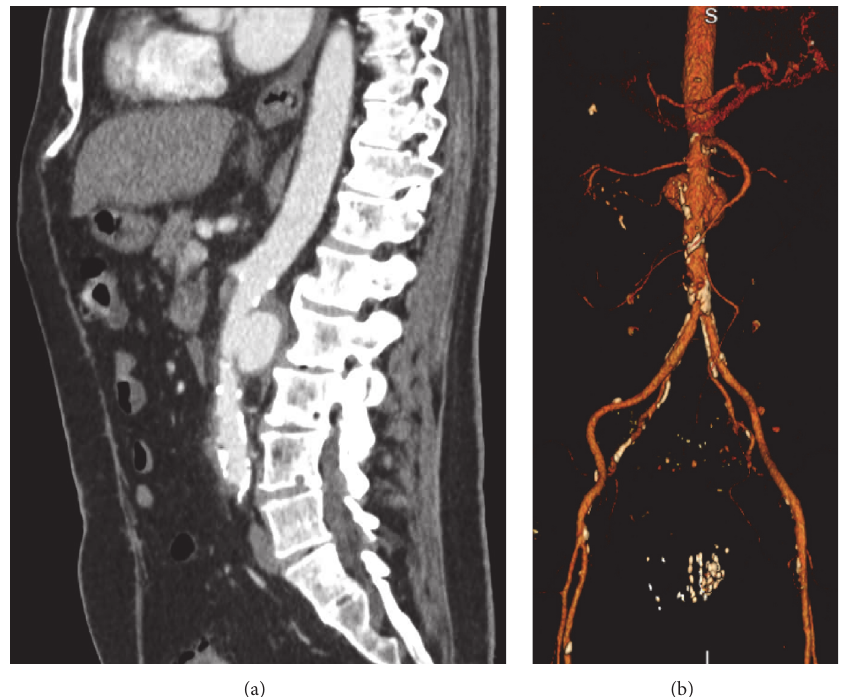
Figure 1: CT image and 3D reconstruction of aneurysm. (a) Sagittal CT shows saccular infrarenal aneurysm with surrounding inflammation. (b) 3D reconstruction demonstrates that the relation of the aneurysm to major abdominal arteries calcifications can be readily